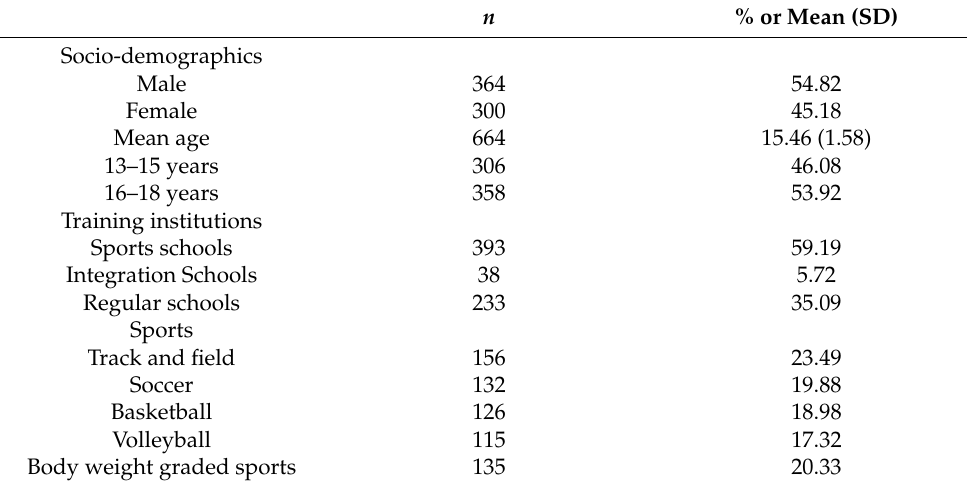
Table 1. Characteristics of the study samples.